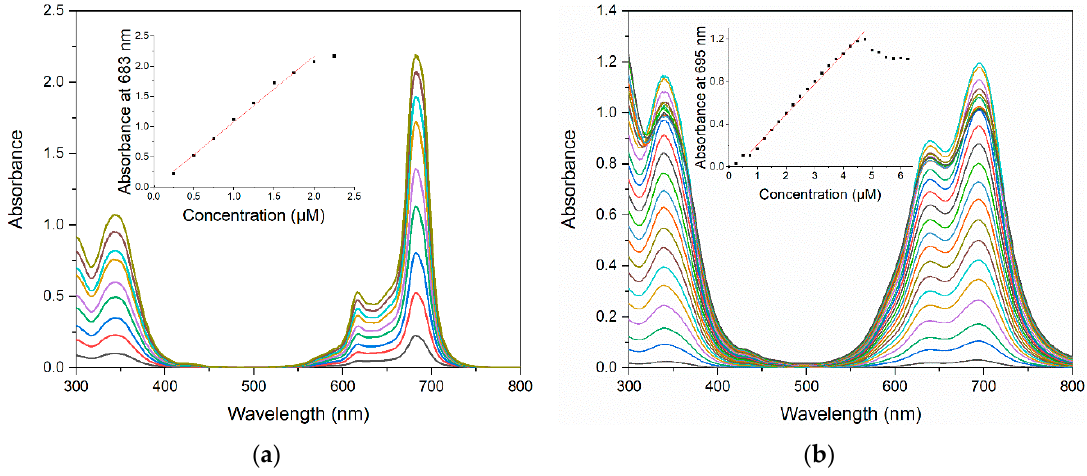
Figure 5. Absorption spectra of different concentrations of bis(PABA)ZrPc in ( a ) DMSO (from 0.25 to 2.2 µM) and ( b ) saline (from 0.25 to 6.0 µM) and the results of Beer-Lambert linearity experiment (insets).